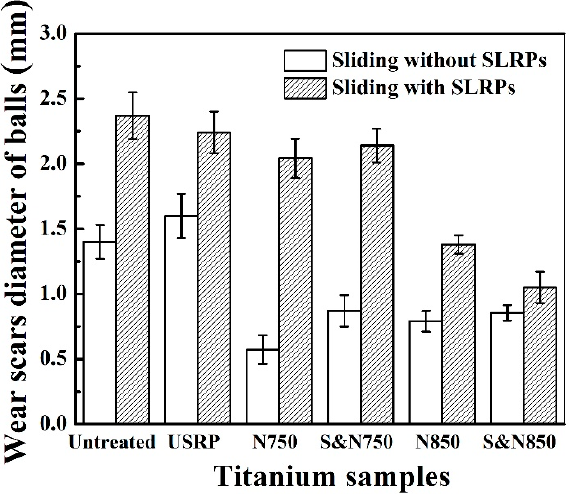
Figure 11. Wear scar diameter of the balls sliding against the Ti treated by USRP pre-treatment and plasma nitriding.